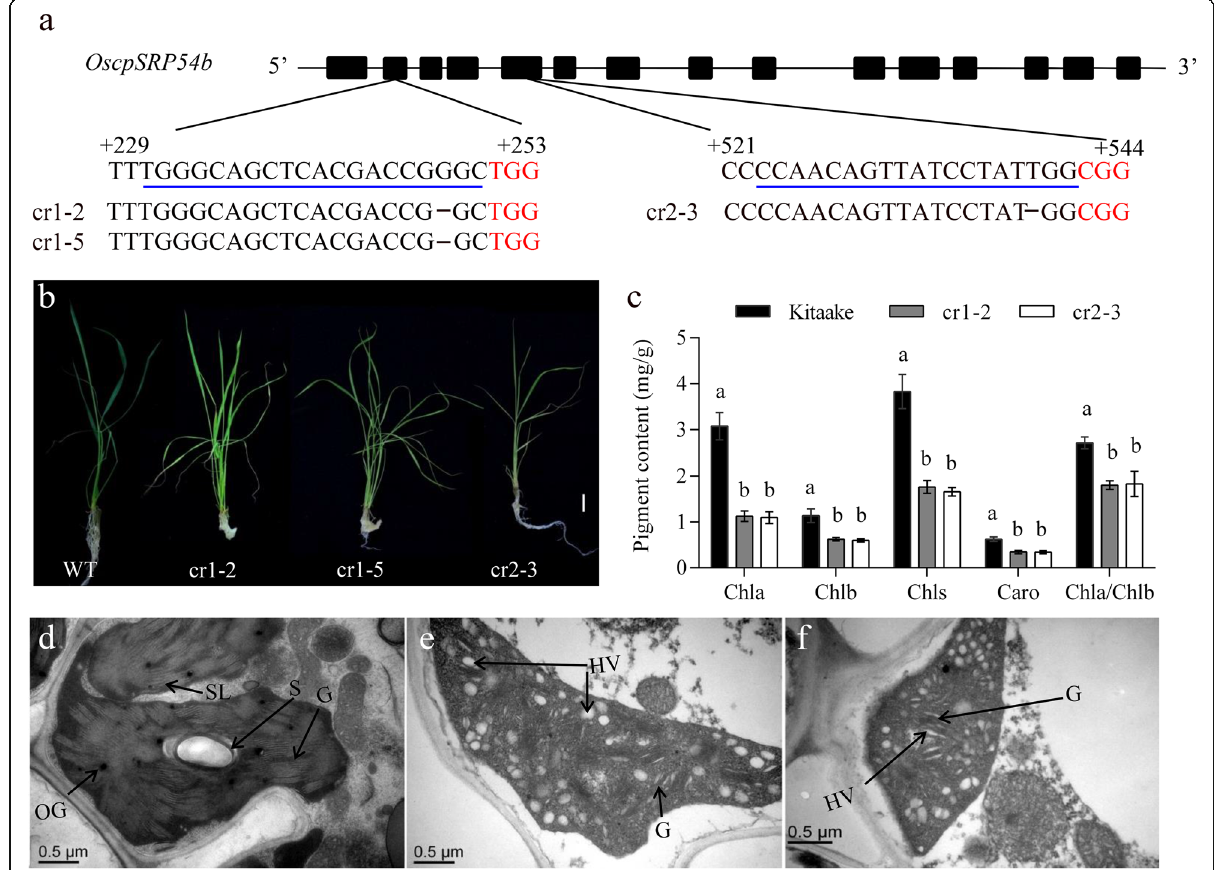
Fig. 5 Functional verification of OscpSRP54b for chloroplast development. a Deletion mutation at the target site in three representative knockout lines generated by the CRISPR/Cas9-mediated editing. cr1 – 2, cr1 – 5 and cr2 – 3 are homozygous mutants carrying 1-bp deletion on both homochromosomes. Black boxes indicate exons and lines indicate introns of OscpSRP54b . The sgRNA target sequence is underlined in blue and the PAM motif is highlighted in red letters, F and R are the forward and reverse primers for qRT-PCR analysis; b Phenotype of Kitaake and OscpSRP54b knockout mutants. Bar = 2 cm; c Pigment contents in 1 week-old leaves of Kitaake, cr1 – 2 and cr2 – 3. Different letters indicate significant differences according to One-way ANOVA and Duncan ’ s test ( p ≤ 0.01); Chloroplast ultrastructure of Kitaake ( d ), cr1 – 2 ( e ) and cr2 – 3 ( f ). G, grana thylakoid; S, starch granule; OG, osmiophilic plastoglobuli; SL, stroma lamellae; HV, hollow vesicle